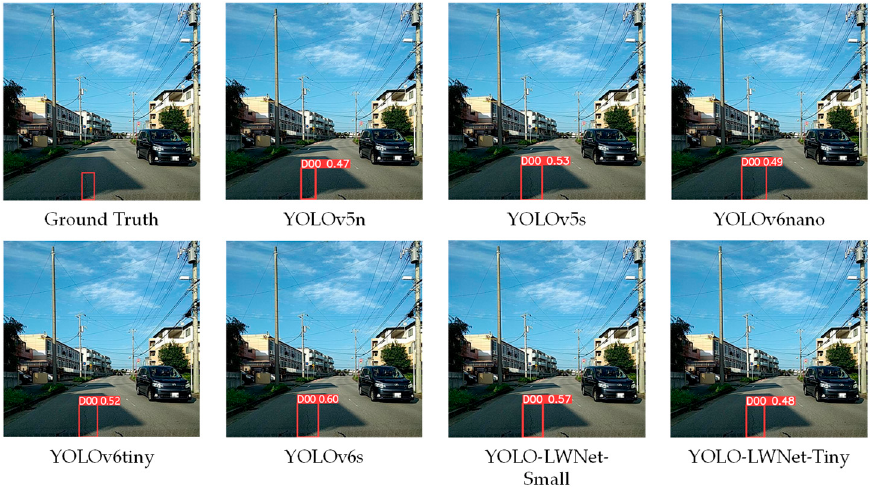
Figure 13. Comparison of the detection of longitudinal cracks (D00).